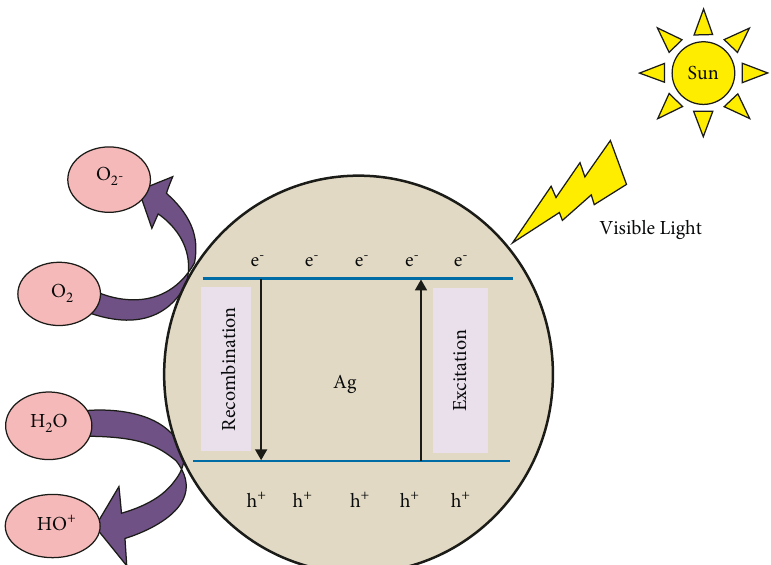
Figure 10: Plausible photocatalytic degradation mechanism of MB dye over Ag-NPs.